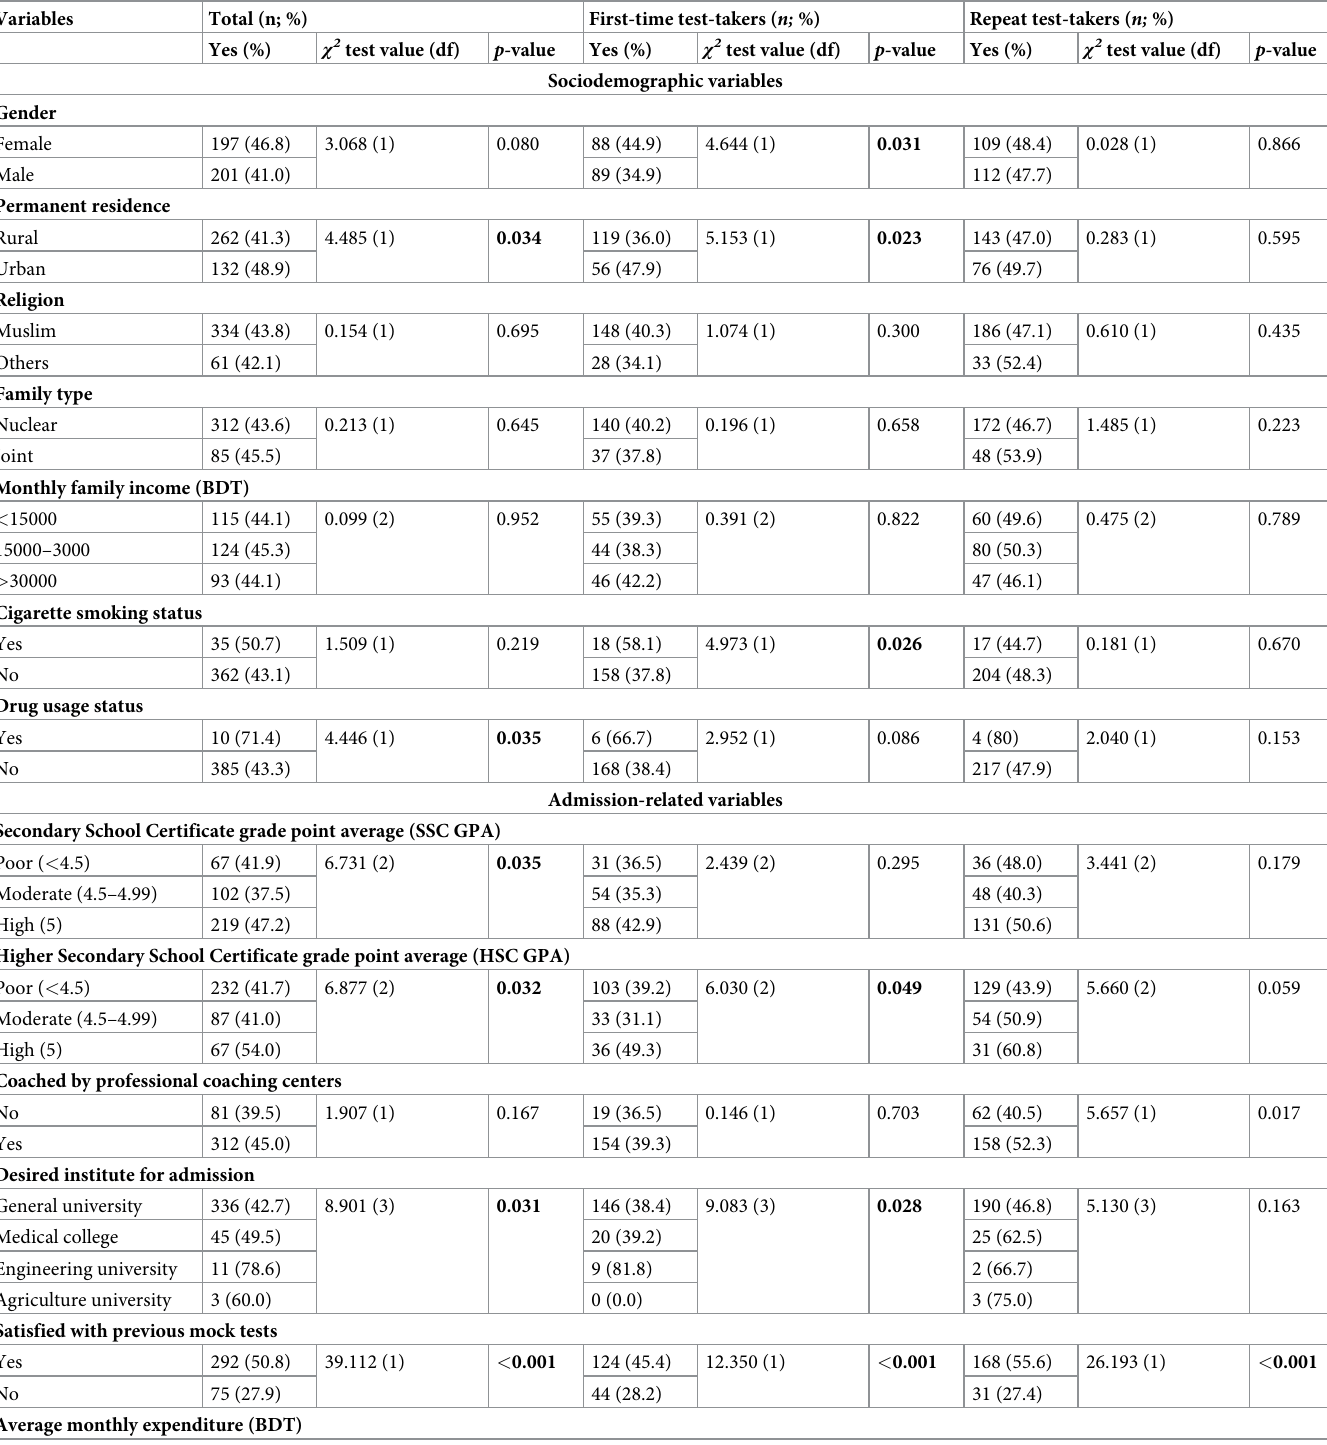
Table 2. Distribution of two-dimensional burnout among first-time and repeat university entrance test-takers.